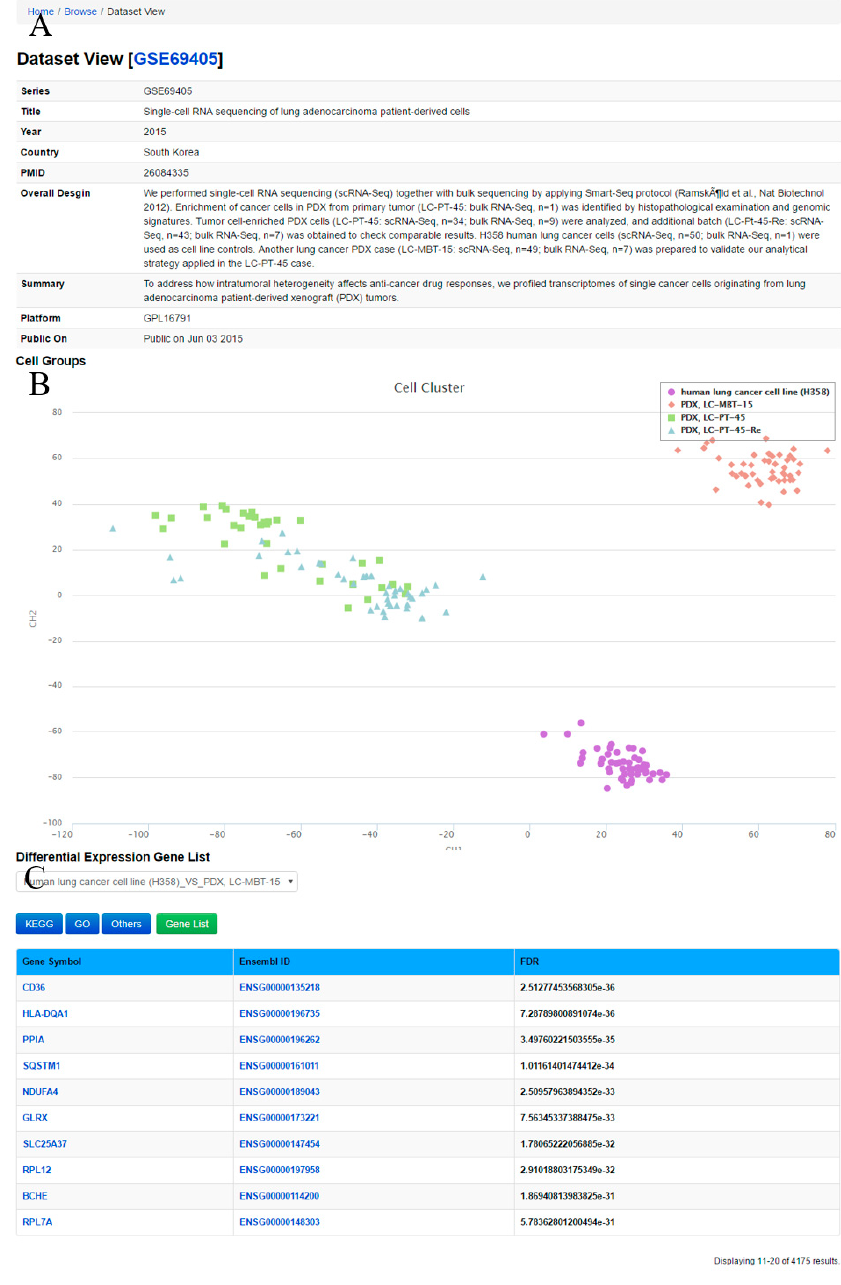
Figure 4 . Dataset View, displaying dataset GSE69405 as an example. ( A ) Metadata information for the dataset; ( B ) Cell groups and cell cluster are presented; ( C ) A list of differentially expressed genes between different groups is provided.